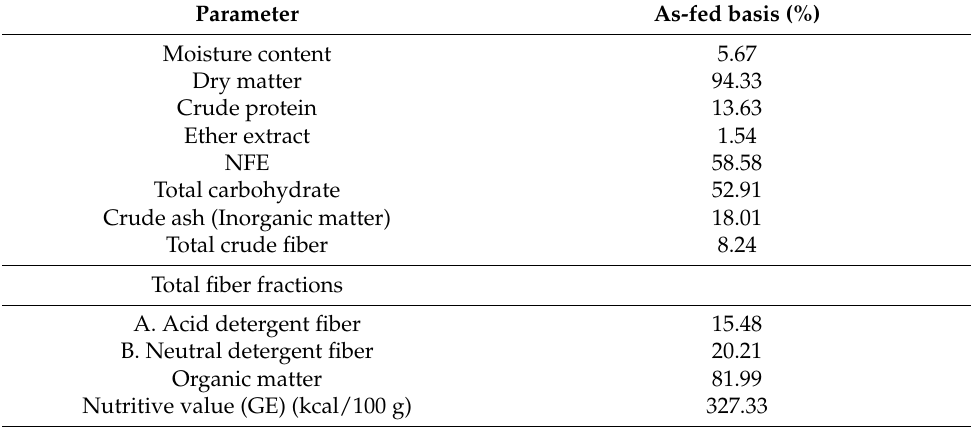
Table 2. Proximate composition of dried leaves of Rumex nervosus 1 .